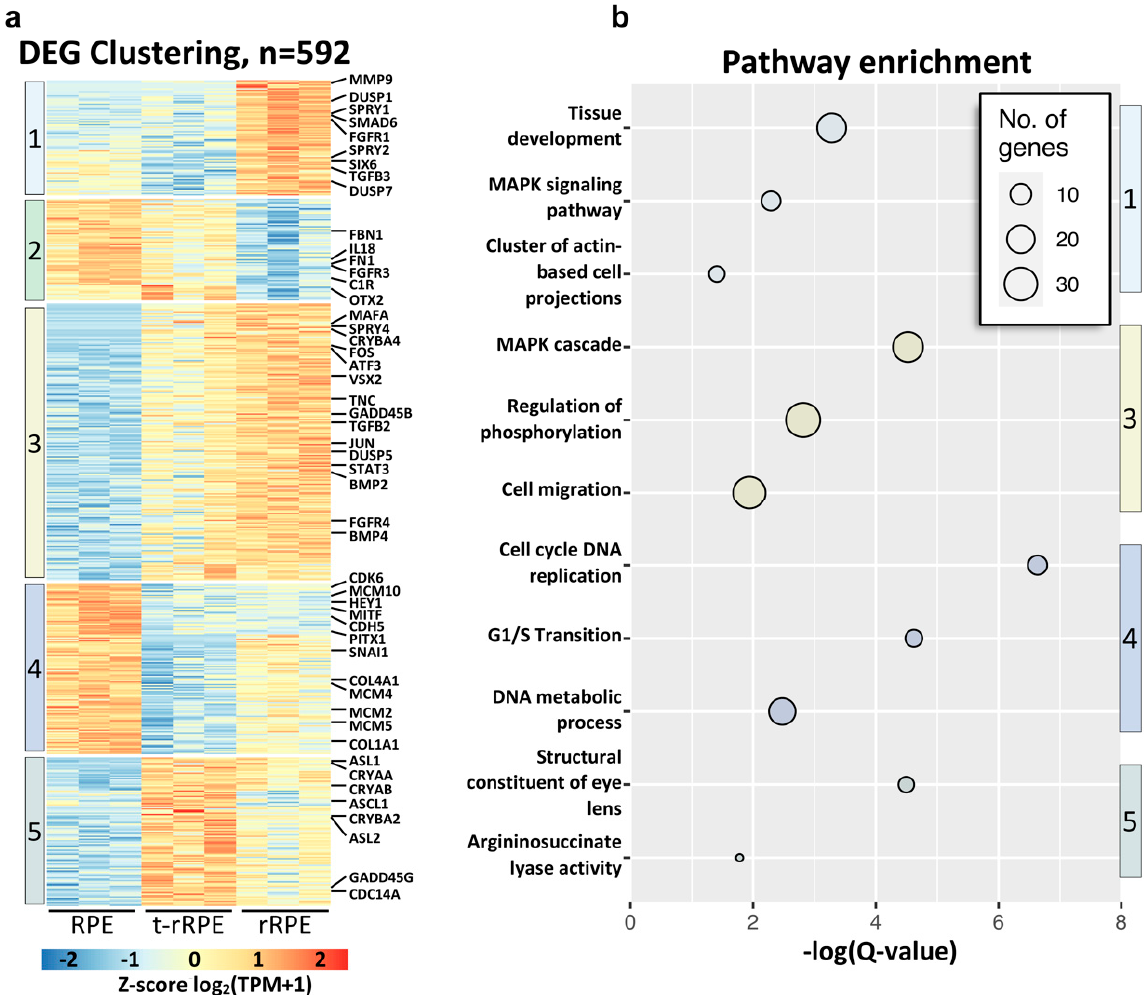
Figure 4. Clustering reveals gene expression dynamics during RPE reprogramming. ( a ) Affinity propagation clustering of 592 non-redundant DEGs delineated five gene clusters adhering to unique expression patterns. The heatmap is row-normalized and notable genes associated with retinal development and regeneration are annotated on the right. ( b ) Bubble chart displays key terms associated with each DEG cluster. The size of each bubble represents the number of DEGs identified for each term; the color of each bubble is associated with the cluster number from ( a ).